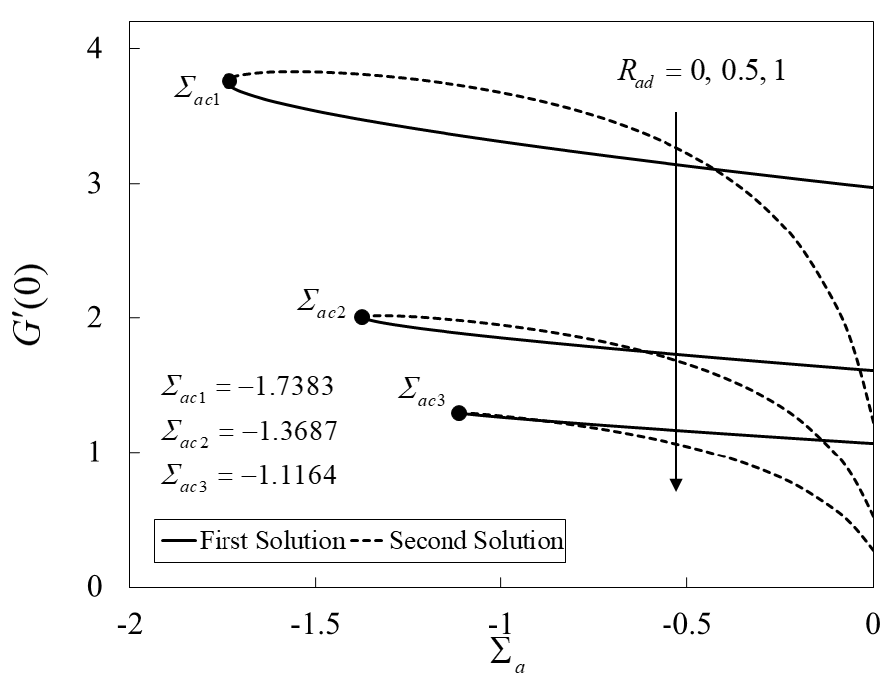
Figure 6. Variation in the local Nusselt number G (cid:48) ( 0 ) with Σ a for different values of R ad .